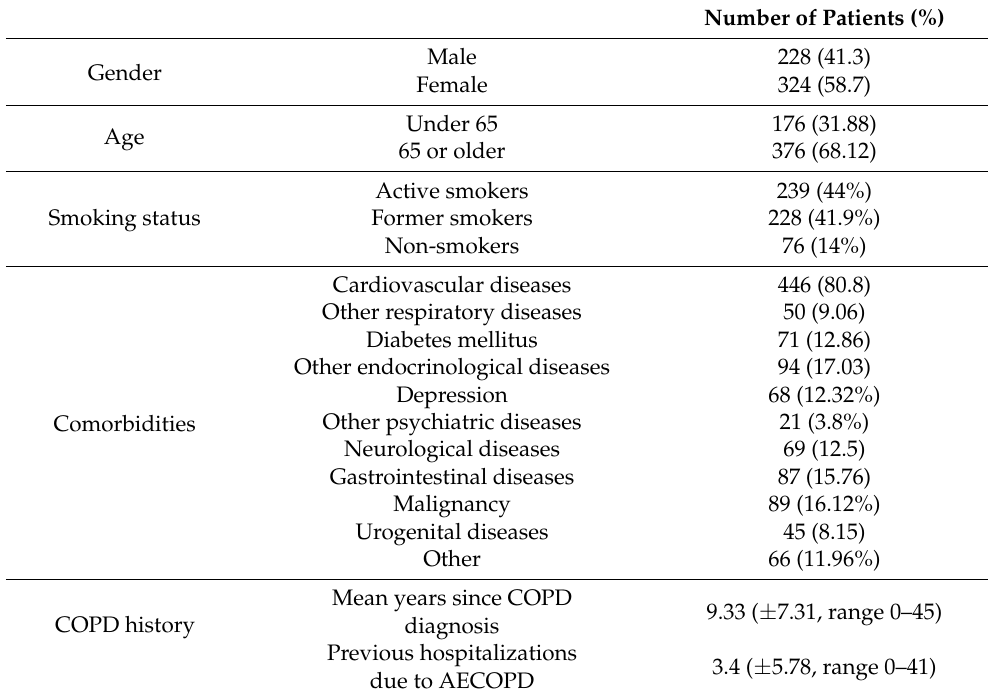
Table 1. Sociodemographic analysis and patients’ medical